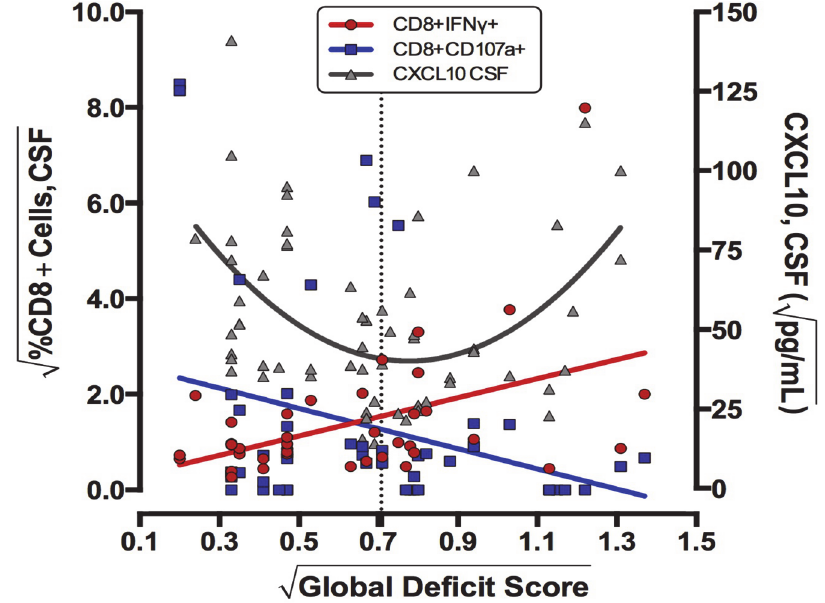
Fig 7. Neurocognitive outcome (GDS) can be viewed as a function of levels of chemoattractant (CXCL10) in CSF combined with the phenotype of CD8+ T-cells (CD107a or IFN γ +) available for recruitment into the CNS. Using all patient visits, best fit lines/curves for constitutive CSF CD8+CD107a (r = 0.28 p = 0.05), CD8+IFN γ expression (r = 0.47 p = 0.001) (both left axis), and CSF CXCL10 (r = 0.51 p = 0.004) (right axis) were plotted as a function of neurocognitive GDS. The dotted line indicates the conventional cut-off for clinically significant NCI, crossing near the inflection point for CXCL10 and the intersection of falling CD107a levels and rising CD8+IFN γ expression. CD8+T-cell expression levels, CXCL10, and GDS were square root